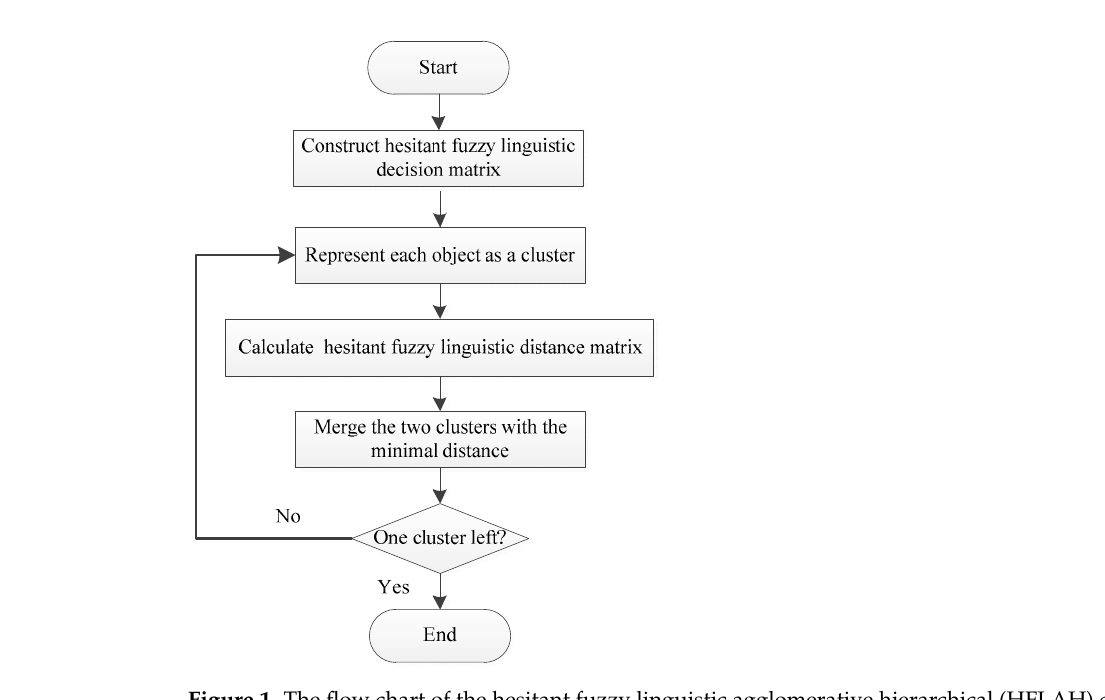
Figure 1. The flow chart of the hesitant fuzzy linguistic agglomerative hierarchical (HFLAH) clustering algorithm.